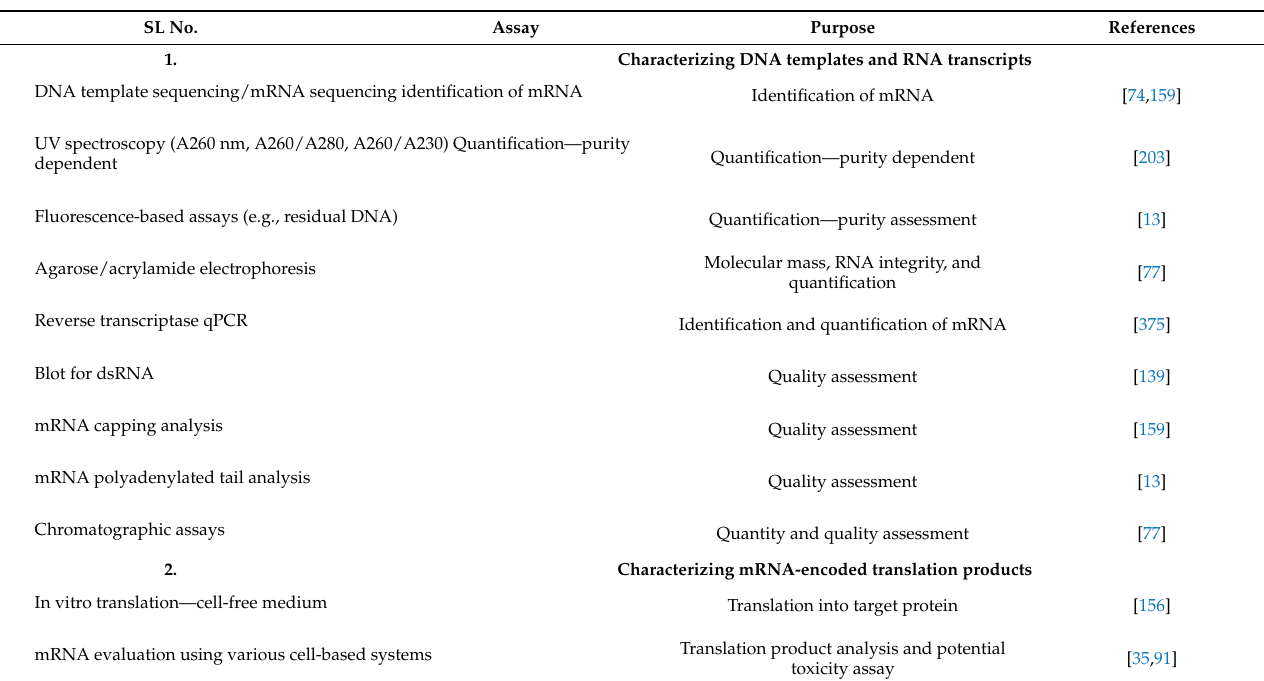
Table 10. Analytical methods to determine and monitor quality attributes and stability of mRNA vaccine bulk drug substance and final drug